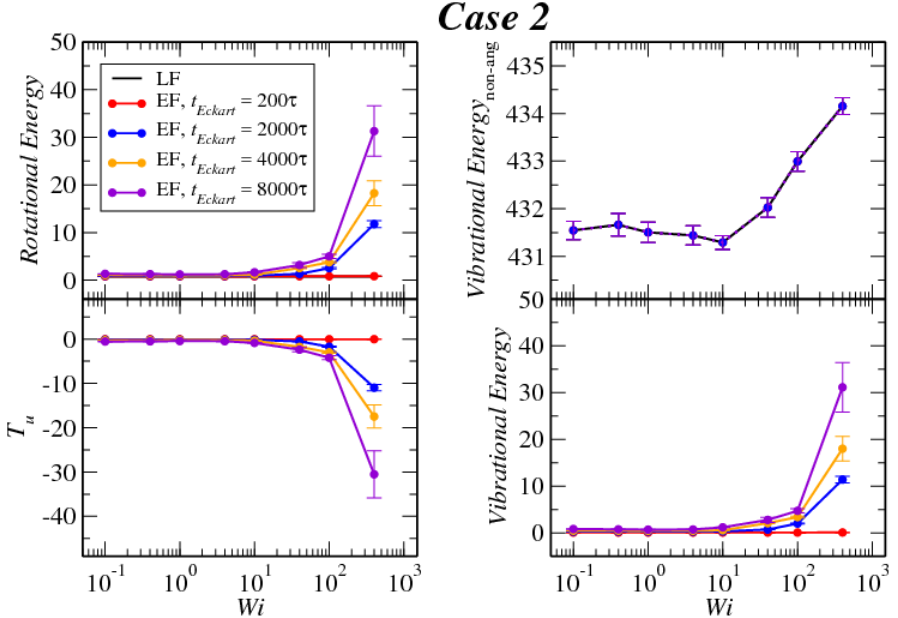
Figure 9. Comparison between the values of the kinetic energy for Case 2 evaluated in both the lab and Eckart frames at different Eckart’s times (Table 2).